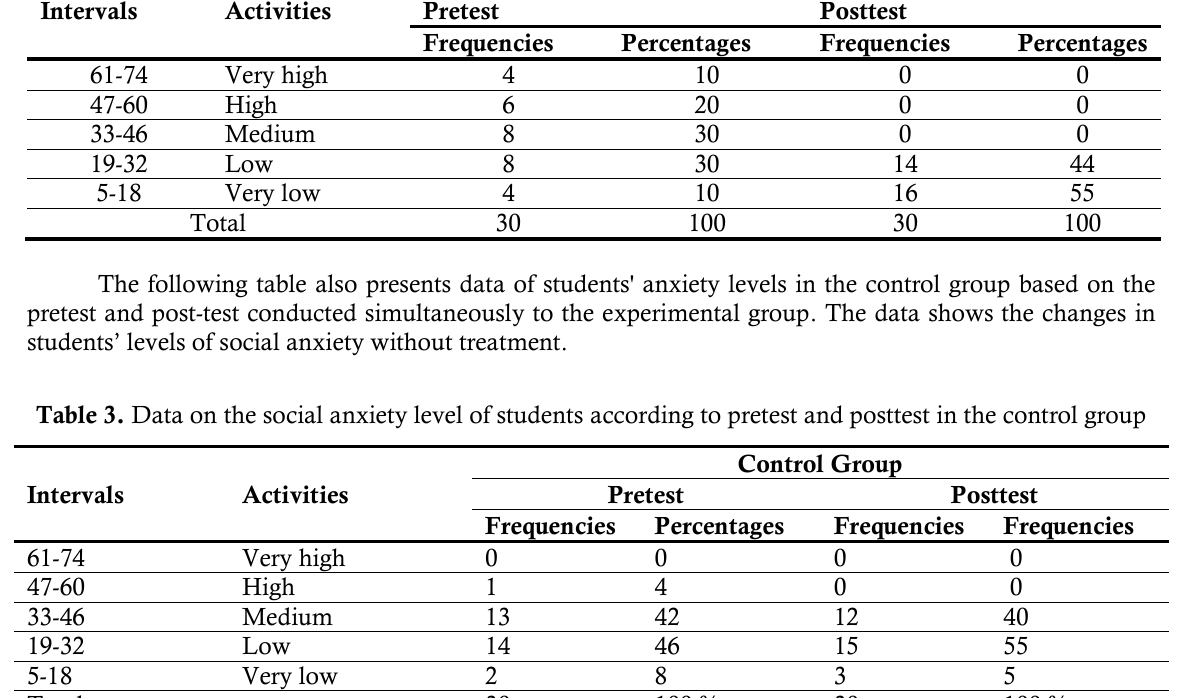
Table 2. Data on the social anxiety level of experimental group students treated with group counseling through behavioral rehearsal approach according to the post-test and pretest Intervals